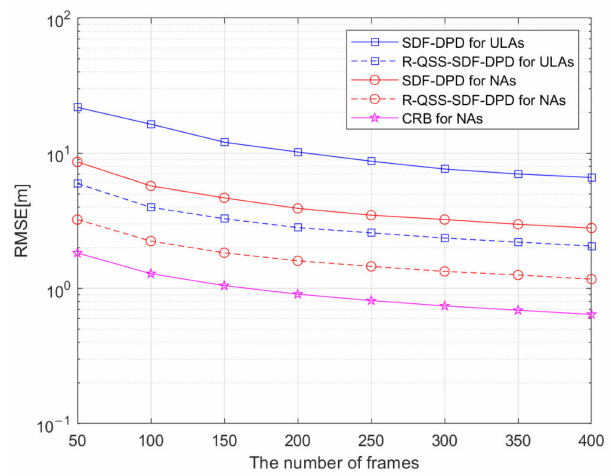
Figure 8. Comparison of SDF-DPD and R-QSS-SDF-DPD algorithms by RMSE versus the number of